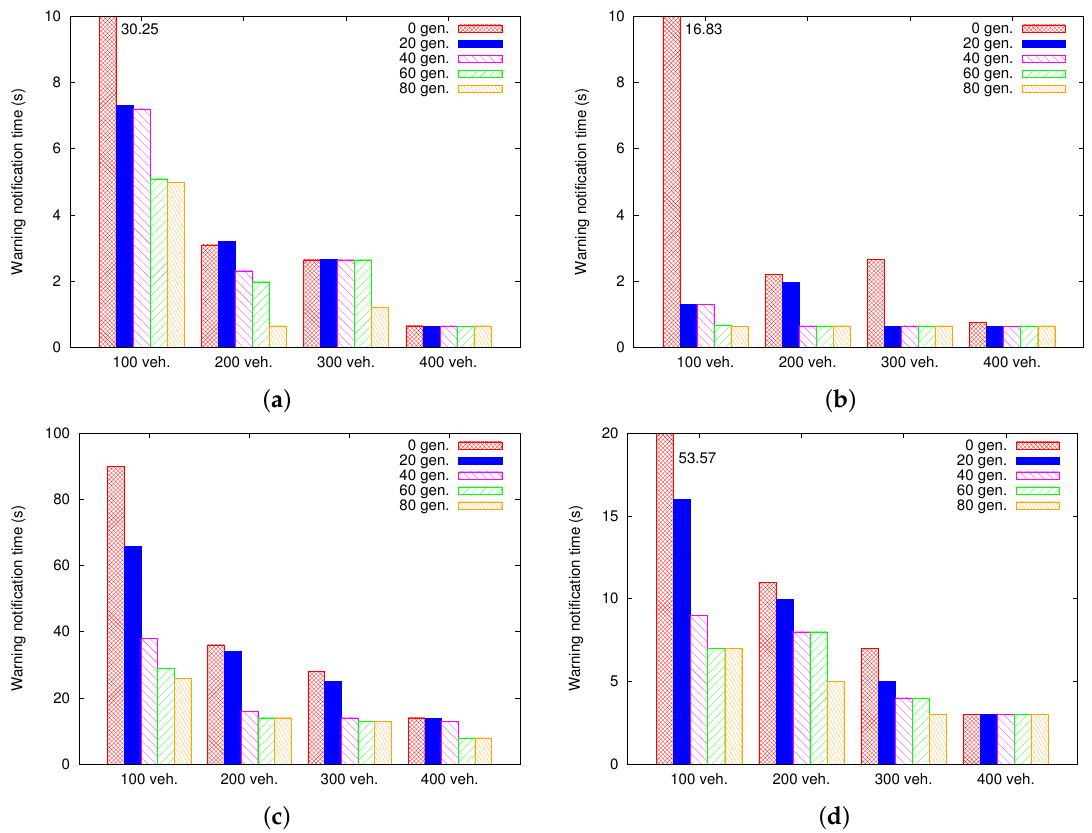
Figure 9. Evolution of warning notification time for each vehicle density: Madrid and Valencia scenarios. ( a ) Four RSUs: Madrid; ( b ) 9 RSUs: Madrid; ( c ) 4 RSUs: Valencia; ( d ) 9 RSUs: